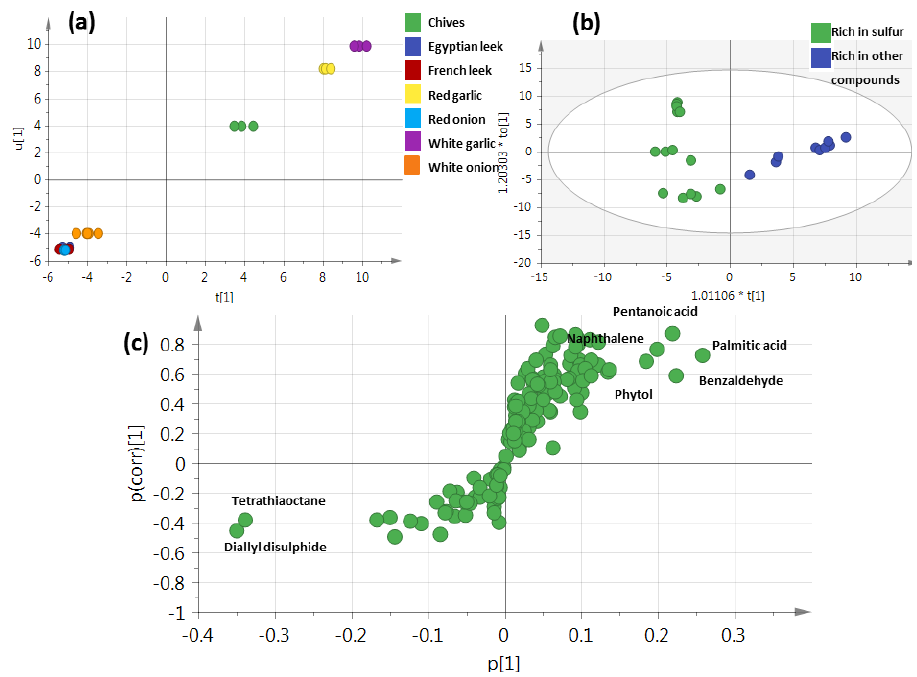
Figure 6. GC-MS-based OPLS-DA score plot ( a ) derived from modeling volatile metabolites of plants rich in sulphur compounds versus plants rich in other compounds (n = 3). ( b ) OPLS French leek, Egyptian leek, and red onion that clustered at left in one class against the other species that clustered at right. ( c ) The respective loading S-plots showing the covariance p [1] against the correlation p [6] [1] of the variables of the discriminating component of the OPLS-DA model are depicted in ( c ). Cut-off values of p < 9.09758×10 -4 were used. Designated variables are highlighted and identifications are discussed in the text.